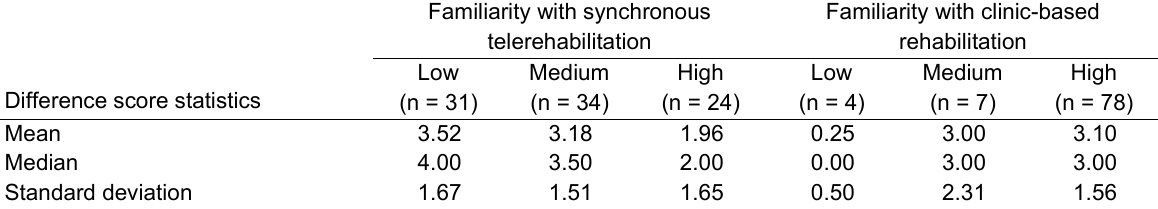
Descriptive Statistics for Familiarity Subgroups Regarding Service Delivery Recommendation Difference